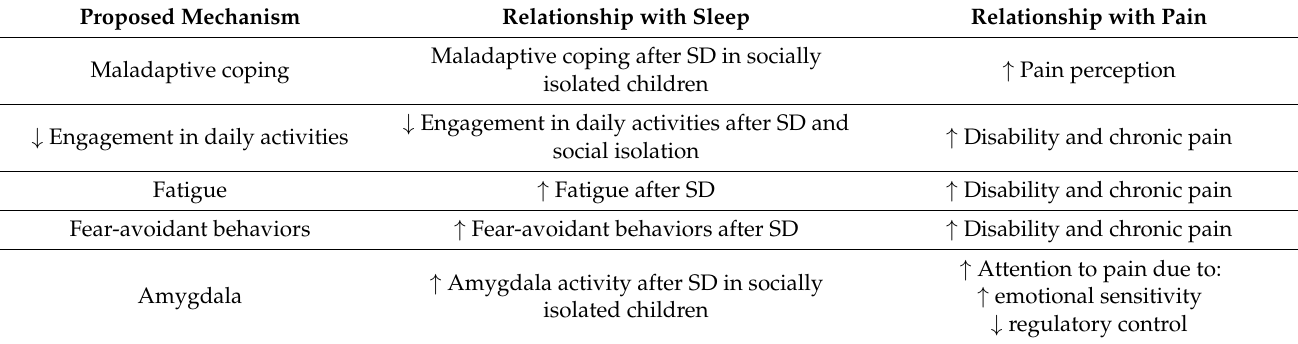
Table 3. Summary of mechanisms to explain the effect of sleep on the social component of pain. Proposed